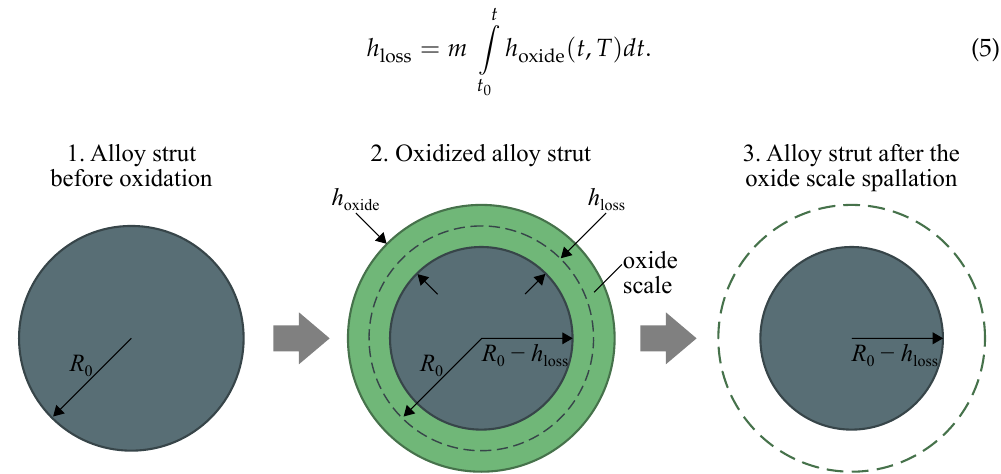
Figure 4. Scheme of oxide scale formation with h loss definition.